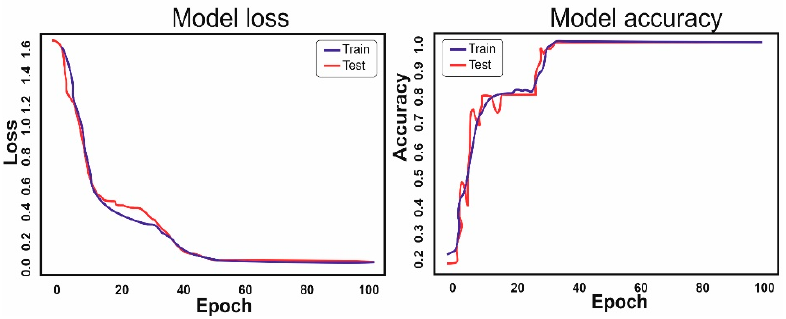
Figure 9. Graphs of the loss function and accuracy when training a universal ANN.